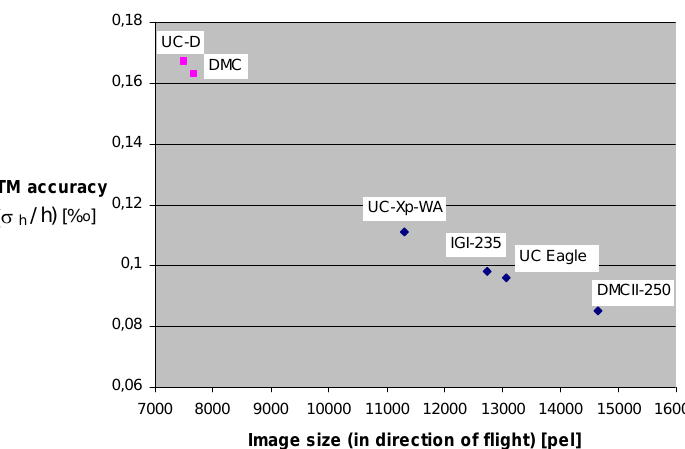
Figure 2. Relative elevation accuracy of digital aerial cameras